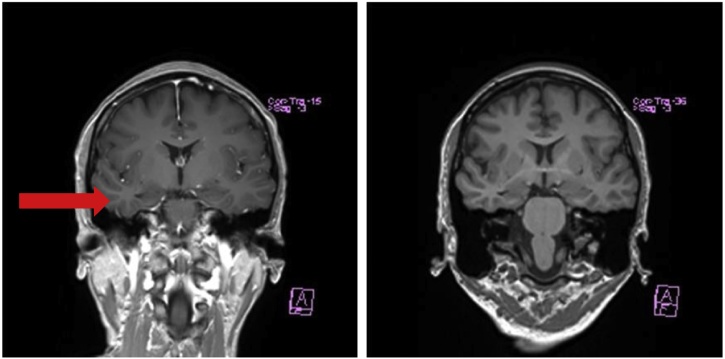
MRI Brain (coronal views) showing asymmetry of the lateral ventricles, with a prominent right temporal horn of the lateral ventricle, indicative of decreased volume in the right hippocampal region.